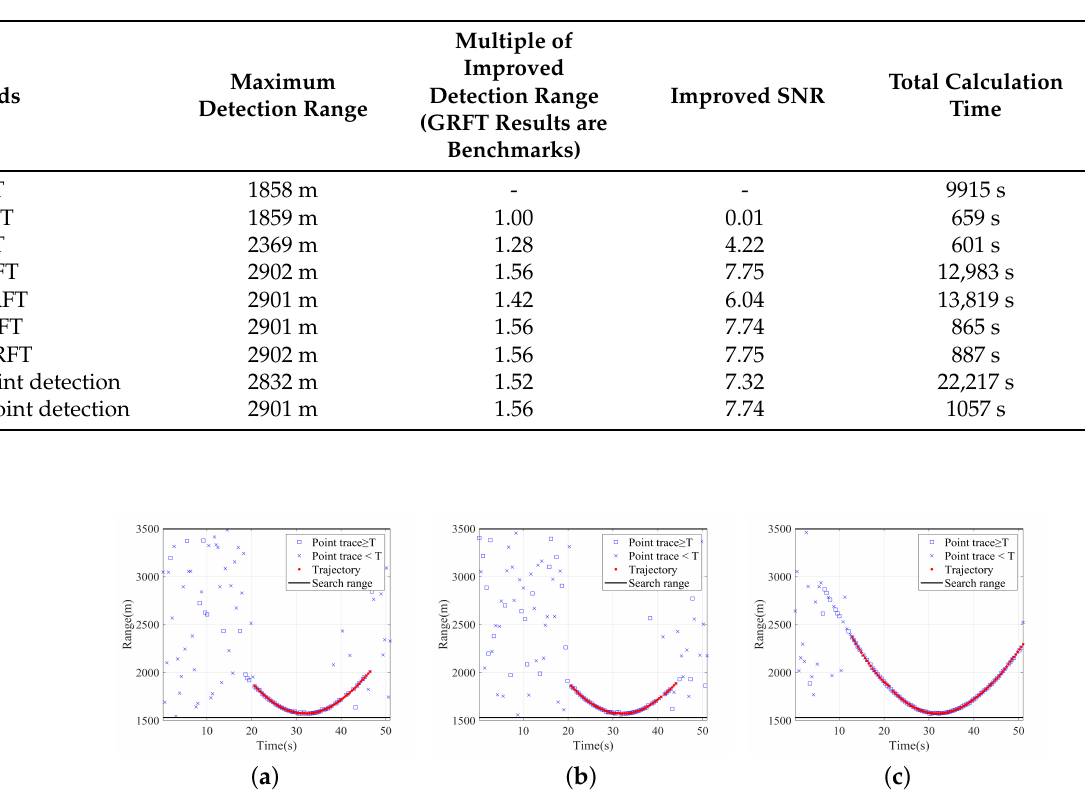
Table 5. Target Parameters & Processing Parameters